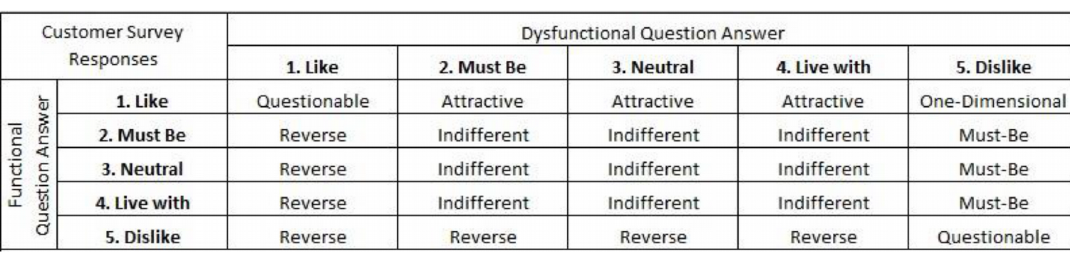
Figure 3. Procedure to designate quality attributes according to the responses to functional and dysfunctional questions